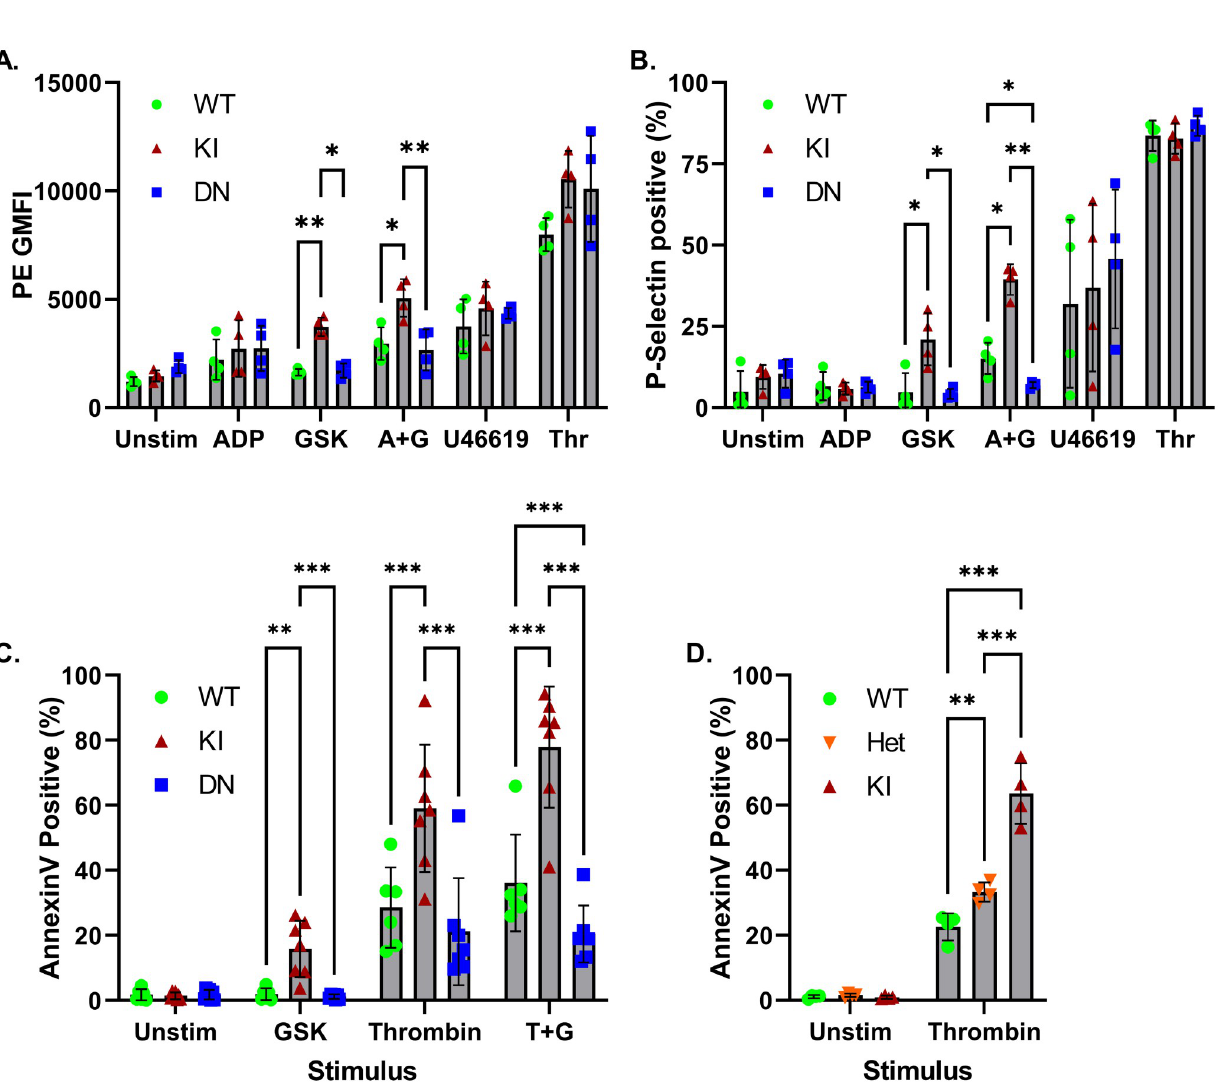
Fig 3. Differential effects of Trpc6 genotype on agonist-induced integrin α IIb β 3 activation, P-selectin surface expression, and phosphatidylserine exposure. A-B, washed platelets from WT, KI, and DN mice were stimulated with the indicated agonists (A+G, ADP plus GSK; Thr, thrombin) in the presence of PE-conjugated anti-JON/A antibody (targeting activated integrin α IIb β 3) and FITC-conjugated antibody directed at P-selectin, fixed, and analyzed by flow cytometry. Geometric mean PE fluorescence intensity (A), and percentage of platelets with positive FITC labeling (B), are shown; n = 4 mice per genotype. Two-way ANOVA with Tukey’s multiple comparisons test. Only statistically significant pairwise comparisons between genotypes subject to the same stimulus are shown. C-D, washed platelets from the indicated Trpc6 mice (Het, Trpc6 +/E896K ) were treated with the indicated stimuli, stained with anti-CD41 antibody and Annexin V, and subject to flow cytometry. The percentage of CD41 positive platelets staining for Annexin V is shown. C, percentage of Annexin V stained platelets from three Trpc6 genotypes left unstimulated (unstim), treated with GSK, thrombin, or thrombin plus GSK (T+G); n = 6–7 mice per genotype. Mixed-effects analysis with Tukey’s multiple comparisons test. D, Annexin V staining of platelets from wild-type, heterozygous and homozygous Trpc6 E896K knock-in mice at baseline and after thrombin stimulation; n = 4 per group. Two way ANOVA with Sidak’s multiple comparisons test. Only statistically significant pairwise comparisons are